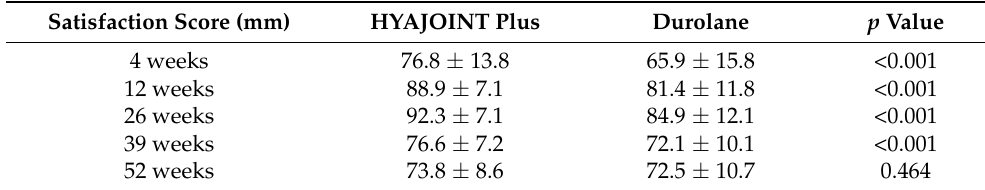
Table 4. Comparison of satisfaction score between